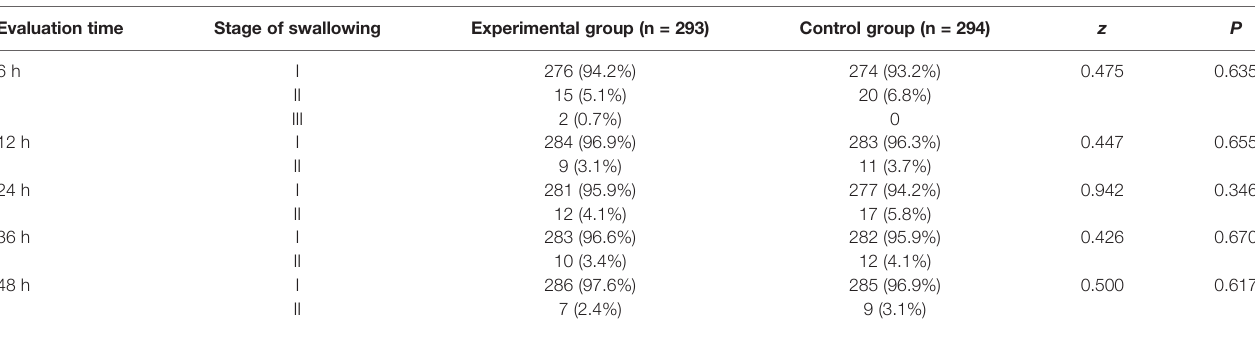
TABLE 5 | Comparison of swallowing function between the two groups